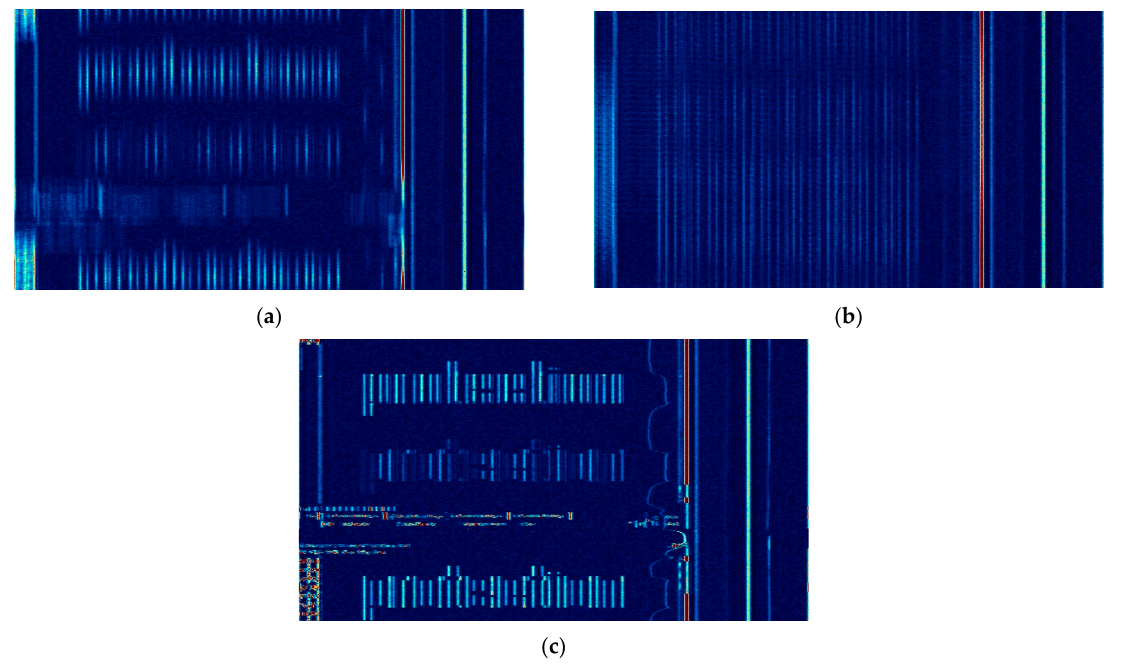
Figure 16. Images reconstructed from the revealing emission signal measured at the frequency f o = 558 MHz, for the number of lines of this image determined in accordance with the criterion of the maximum value of the measures presented in Figure 15: ( a ) the number of image lines determined in accordance with method V ( B = 803, the number of lines smaller than required), ( b ) number of image lines determined in accordance with method II ( B = 823, the number of lines bigger than required), ( c ) number of image lines determined in accordance with method I, III, IV, VI, and VII ( B Corr = 806, correct number of lines).